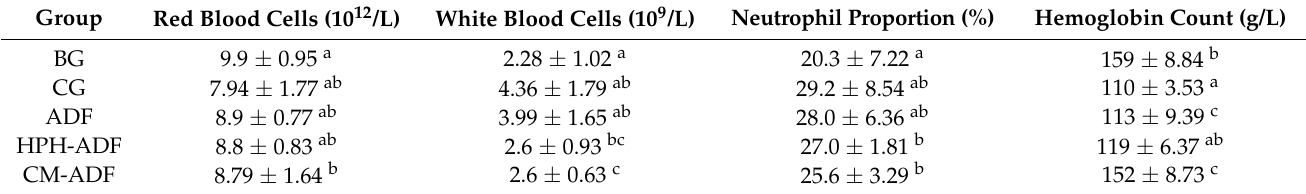
Table 6. Blood routine indices in